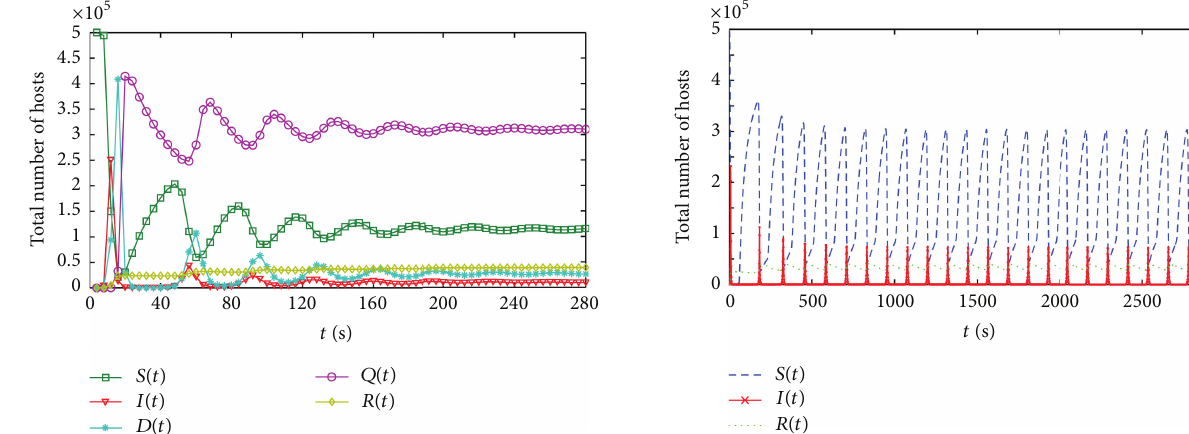
Figure 4: Worm propagation trend of the model when 𝜏 < 𝜏 0 . Figure 5: Worm propagation trend of the model when 𝜏 > 𝜏 0 .